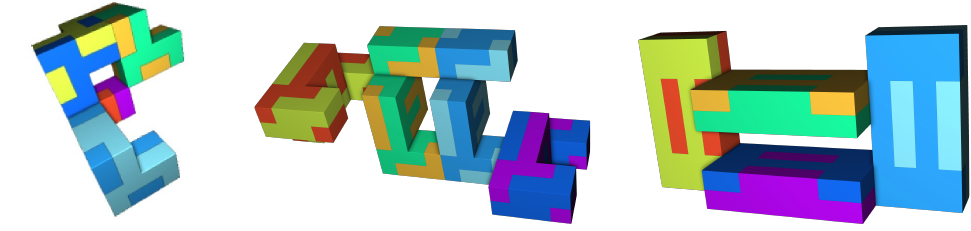
Figure 13. Three dimensional 8 − rep tiles with a